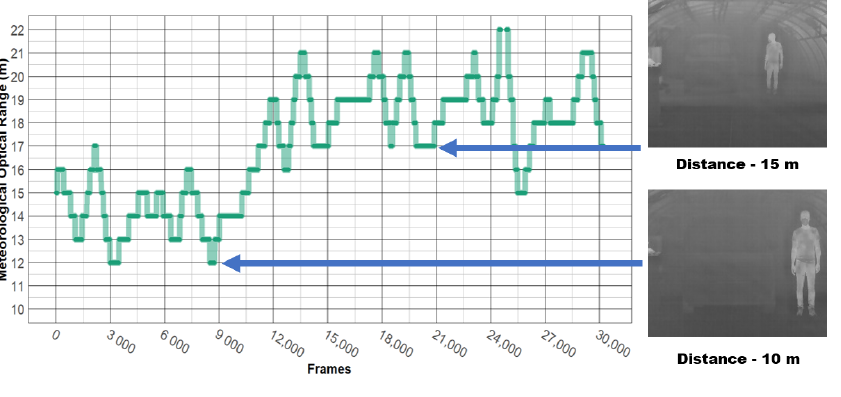
Figure 13. Dynamic scenario, protocol (ii): MOR fixed, targets in motion between 25 and 10